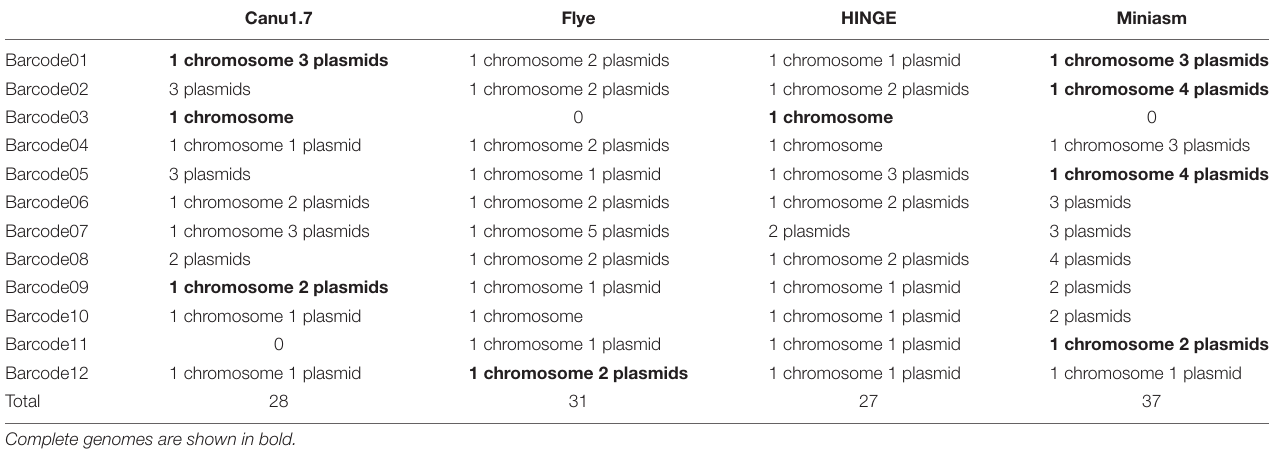
TABLE 2 | Circular sequences deduced by assemblers.